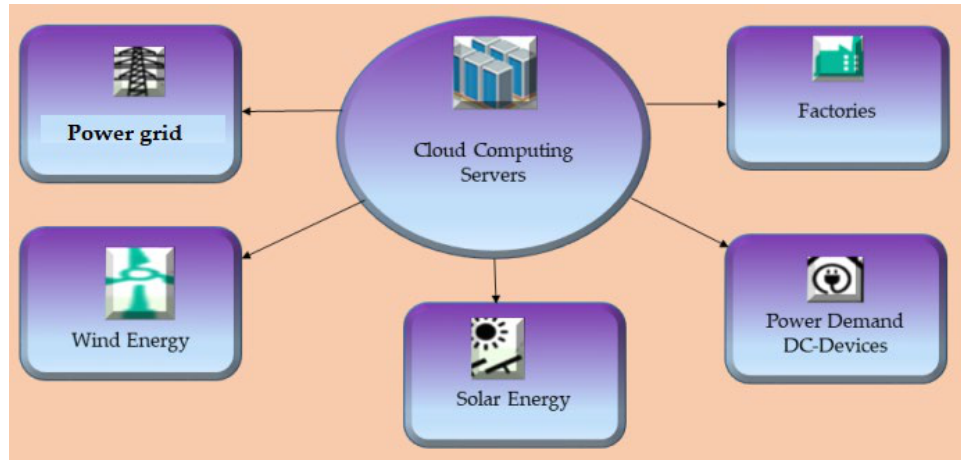
Figure 10. Cloud-Based Detection and Mitigation.